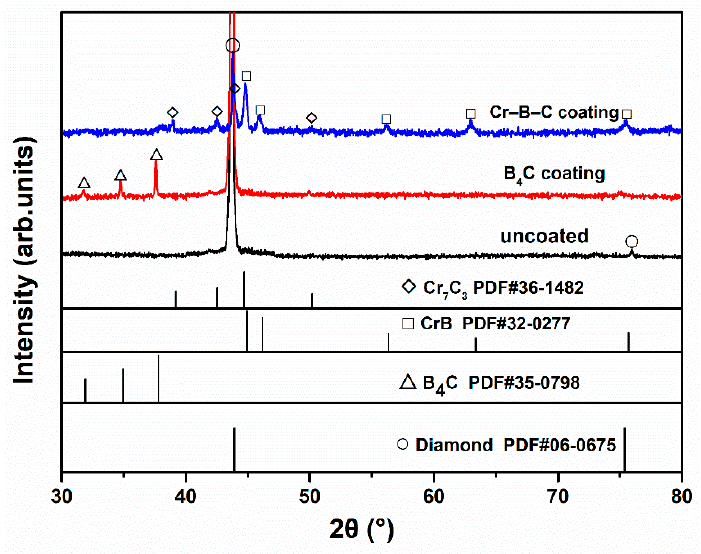
Figure 1. XRD patterns for uncoated diamond particles, diamond particles with B 4 C coating, Cr–B–C coating, respectively.